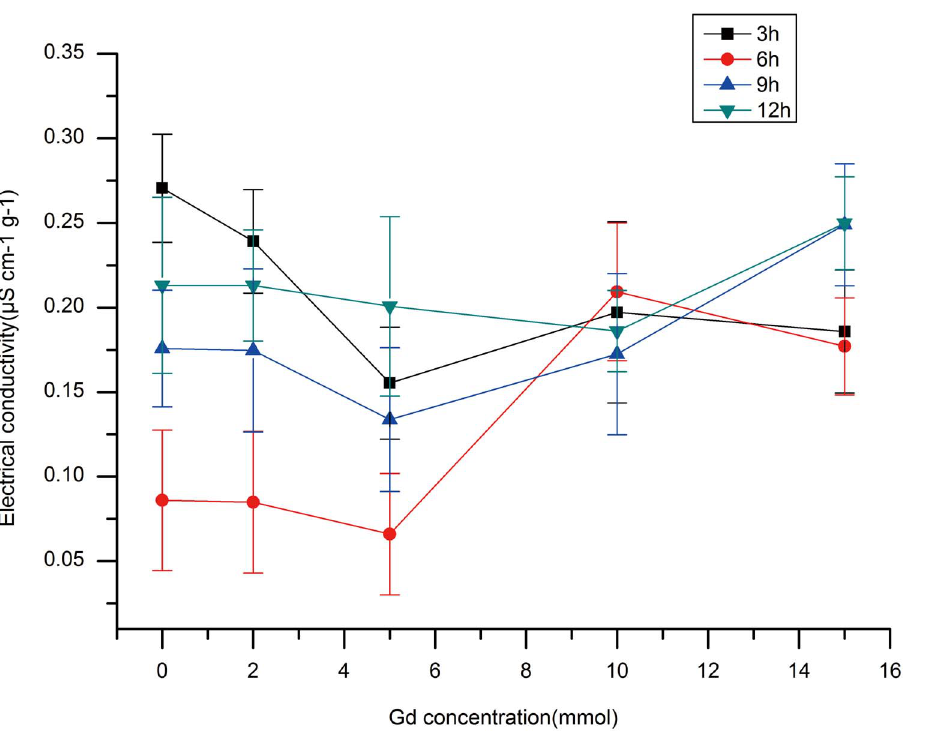
Figure 1. Differences in electrical conductivity (EC) in root samples of rice plants treated with different levels of Gd-DTPA for different periods of time.